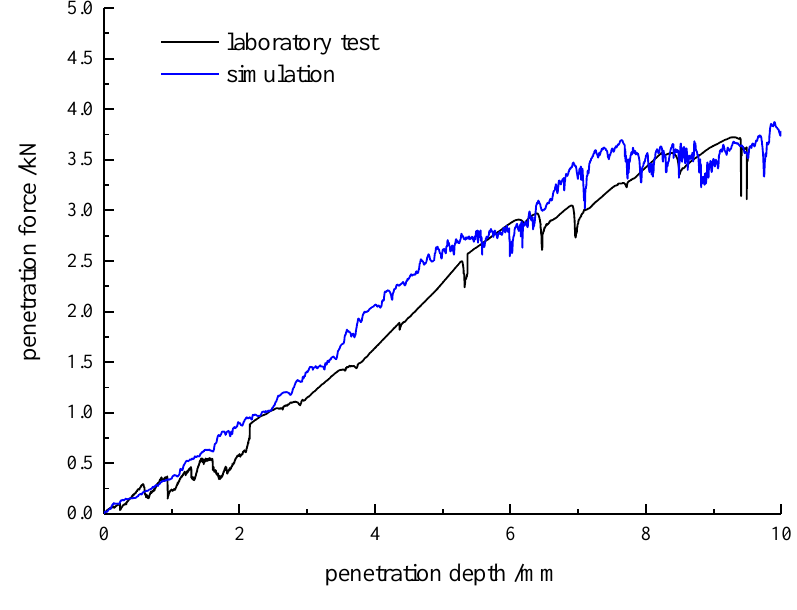
Figure 9. Prediction results of SMA-13.